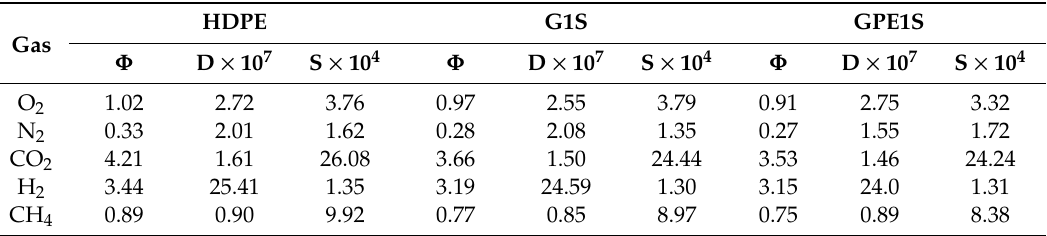
Table 3. Values of the permeability (Barrer), di ff usion (cm 2 s − 1 ) and apparent solubility (cm 3 / cm 3 cmHg) coe ffi cients of di ff erent gases at 30 ◦ C and 1 bar of pressure in HDPE and nanocomposite membranes used in this study and prepared from solution.